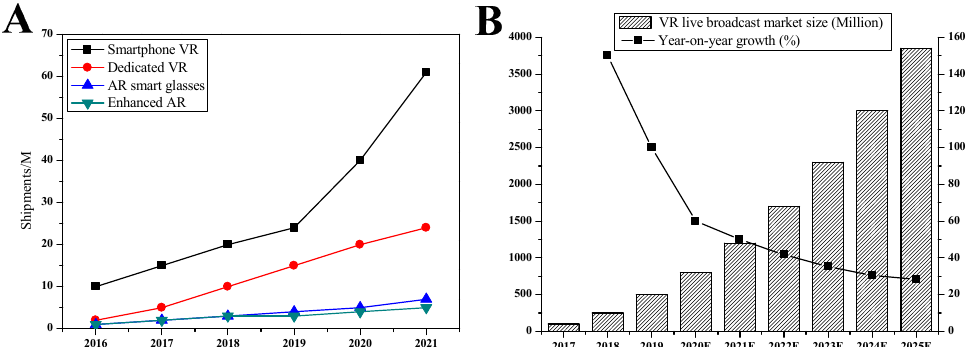
Figure 11. ( A , B ) The changing trend of VR film, television equipment, and live broadcasting market.